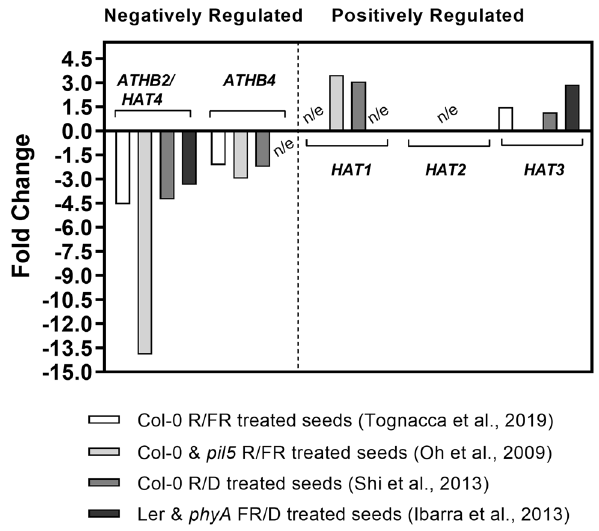
Figure 1. Red light regulates gene expression of HD-ZIP transcription factors in Col-0 seeds. Fold change ratio for HD-ZIP II genes regulated by light in germinating seeds of Arabidopsis in different transcriptomes (phyB- dependent in Shi et al. 2013 and Tognacca et al., 2019; PIL5-dependent in Oh et al. 2009 and phyA-dependent in Ibarra et al., 2013). n/e = no significant